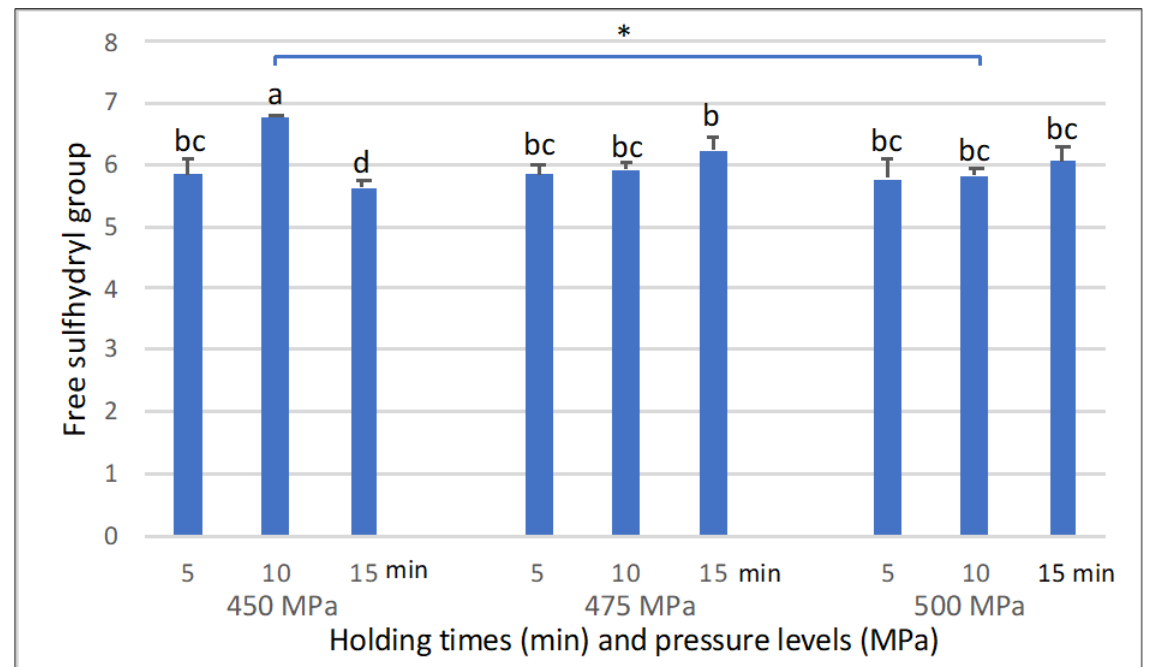
Figure 4. Effect of high-pressure and time on free sulfhydryl group content of strawberry-flavoured egg-white pudding. Different lowercase letters are significant different (p < 0.05). * indicates significant differences (p < 0.05) between group of high-pressure levels.